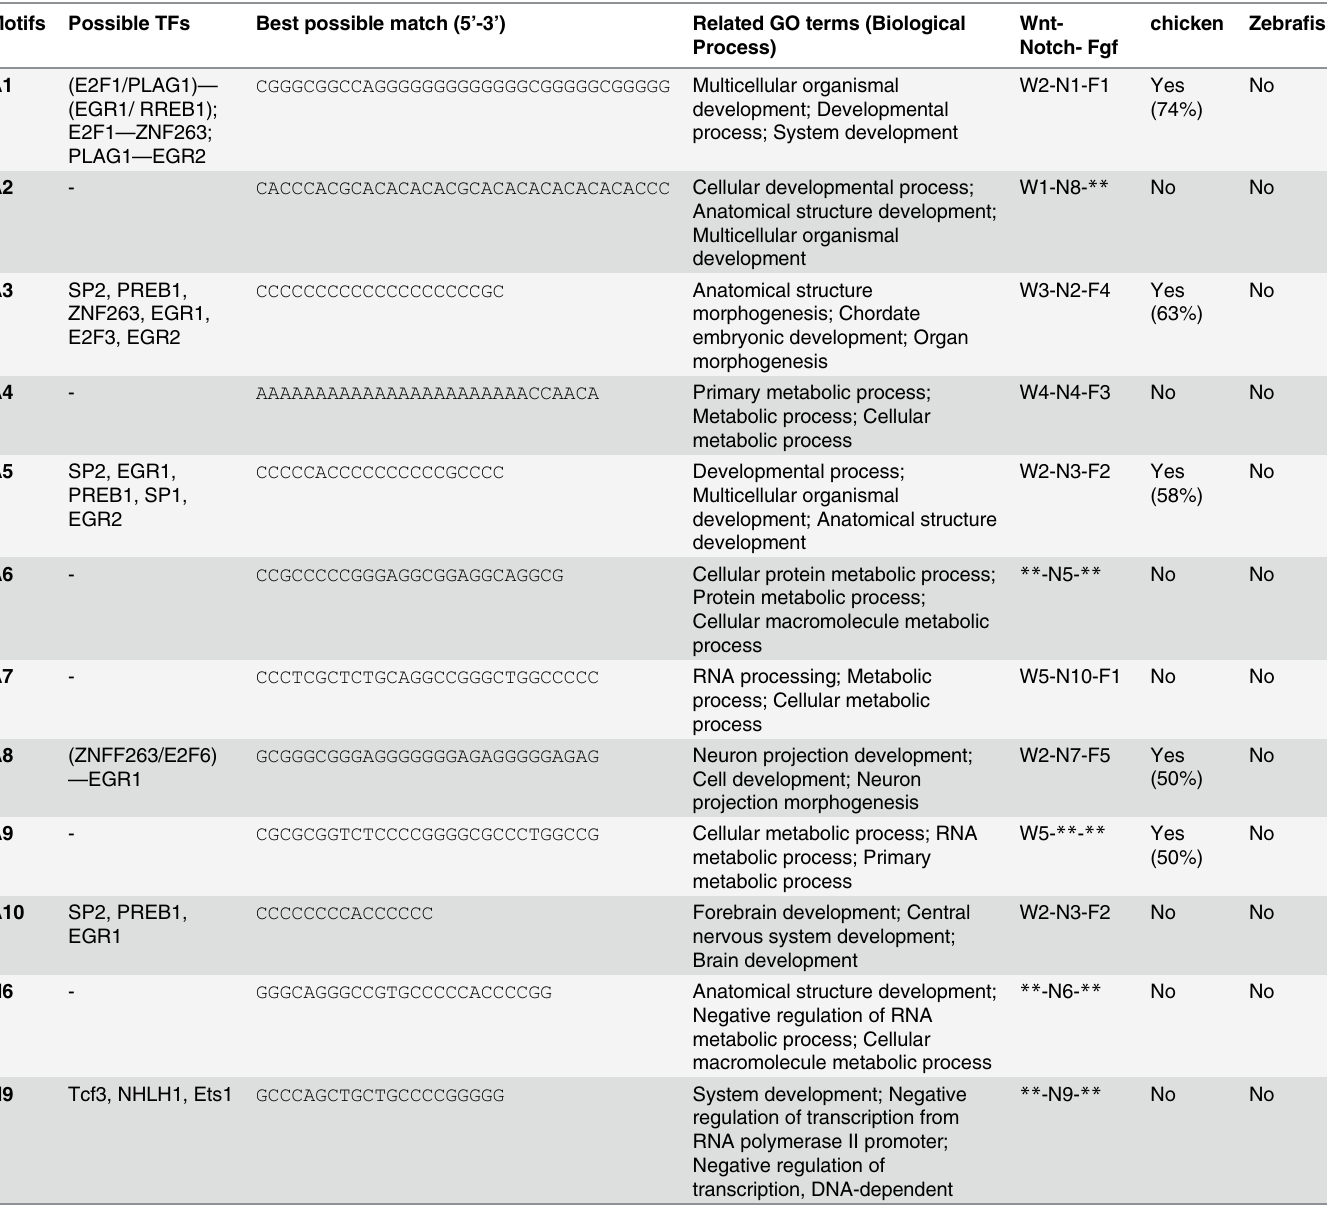
Table 4. De novo identified motifs and their conservation between pathways and species. We tested the reference motif list for pathway conservation and between species conservation. For each motif, we computed the enrichment in known TFBSs databases and reported the corresponding significant TFs. It appears that several TFs may be acting cooperatively to regulate the expression of cyclic genes. We also noticed motif conservation between mouse and chicken as opposed to zebrafish where any of the discovered motifs could be found in the promoters of known cyclic genes. The conservation between spe- cies is given in terms of percentage of reported cyclic genes of the species with the corresponding motif in their promoter region. Motifs Possible